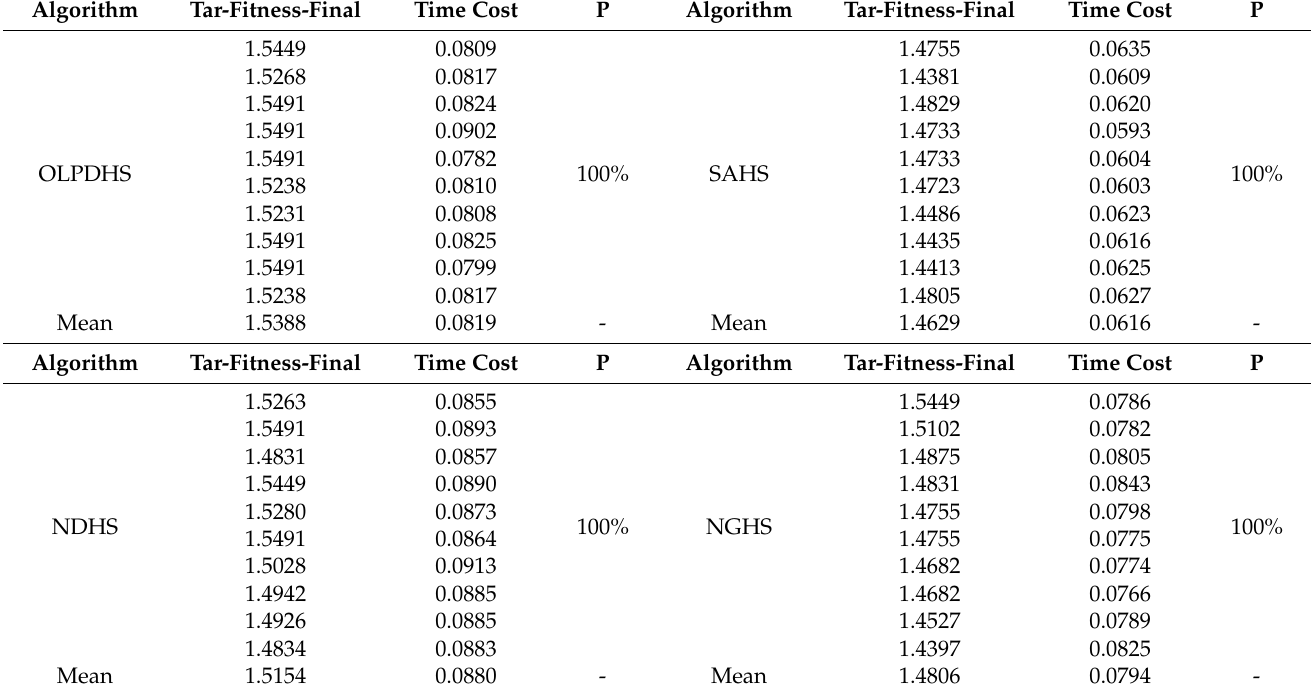
Table 7. The results of 10 times obtained independently by two algorithms.